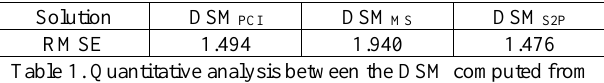
Figure 3. Results visualization from considered solutions.